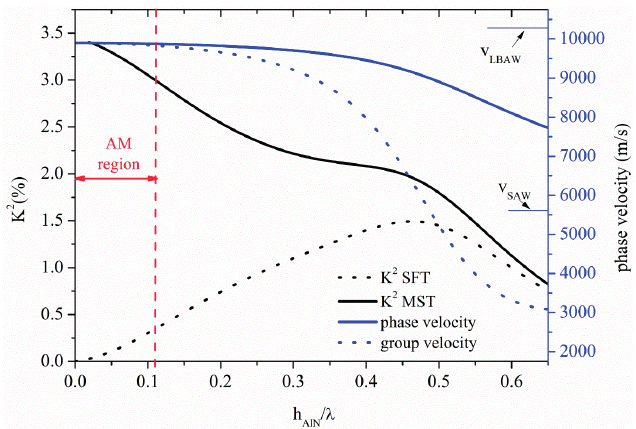
Figure 8. Phase and group velocity, and K 2 dispersion curves of the S 0 mode propagating along the MST and ST configurations on AlN